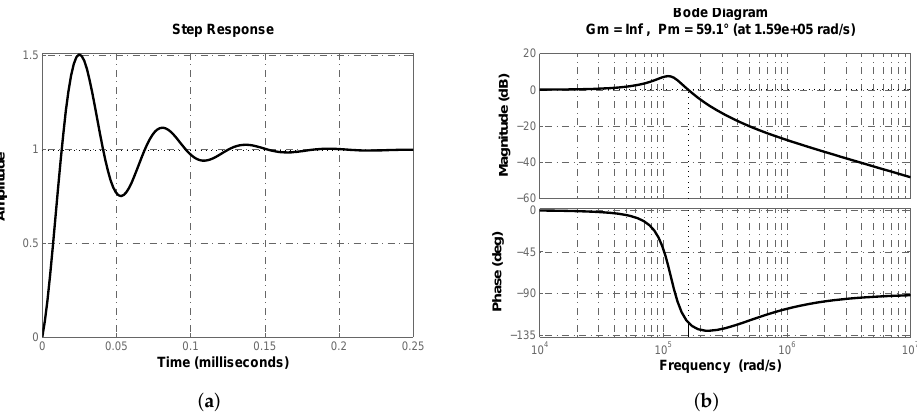
Figure 12. ( a ) Closed-loop step response of plant’s transfer function (2) with classical PD controller